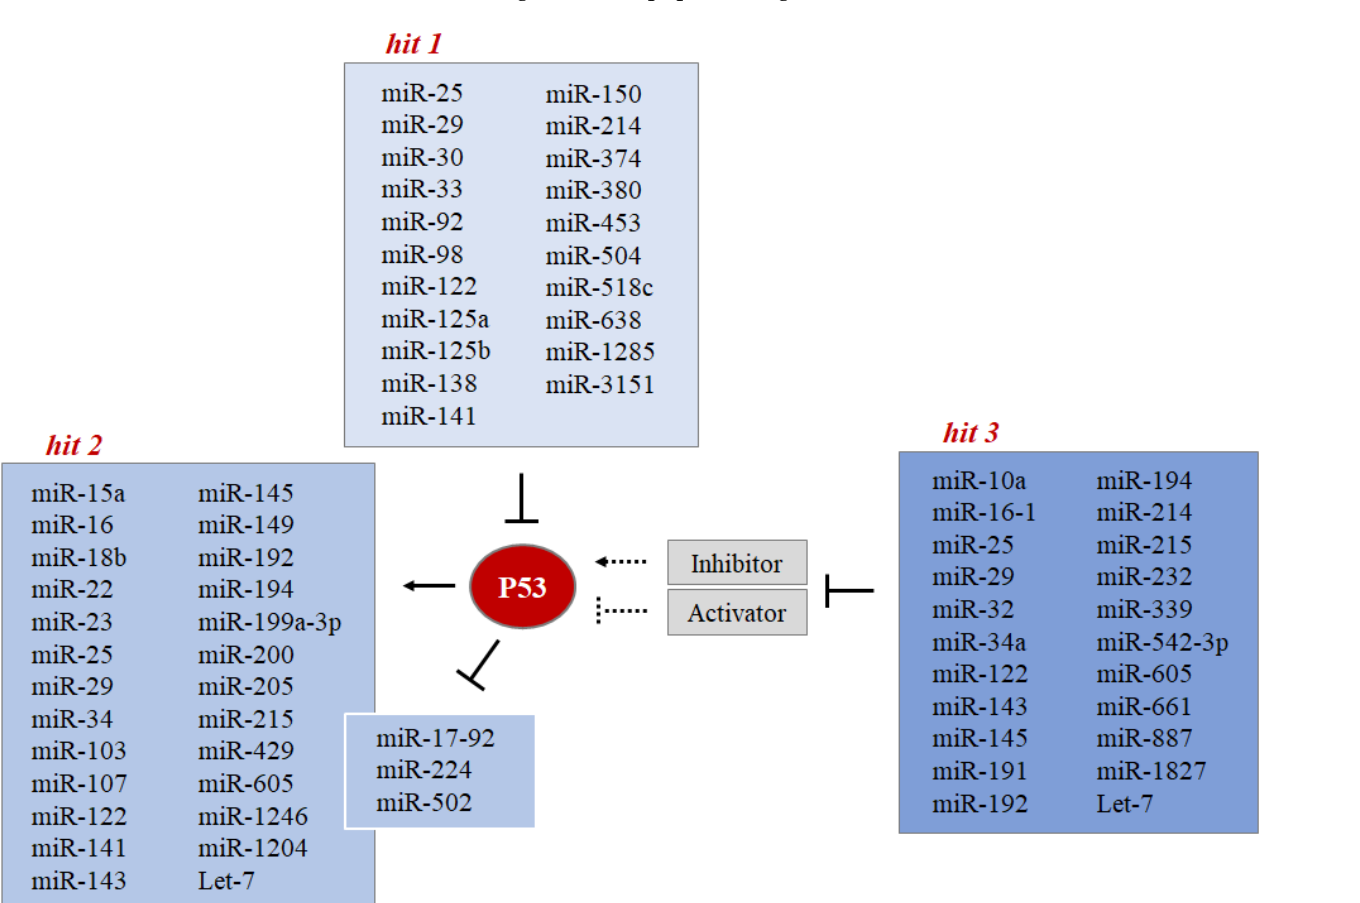
Figure 9. Schematic mechanism of P53–miRNA interaction at multiple levels. MiRNAs directly target P53 by binding the 3′UTR of P53 mRNA. The interaction downregulates the translation of P53 mRNA (hit 1). In a regulatory circuit P53 increases or decreases the expression of miRNAs by inhibiting regulators (hit 2). Furthermore, some miRNAs targeting P53 regulators vary P53 outcomes (hit 3). If the regulators are positive, P53 outcomes culminate in decreases, or, on the other hand, nega- tive regulators lead to a P53 increase.